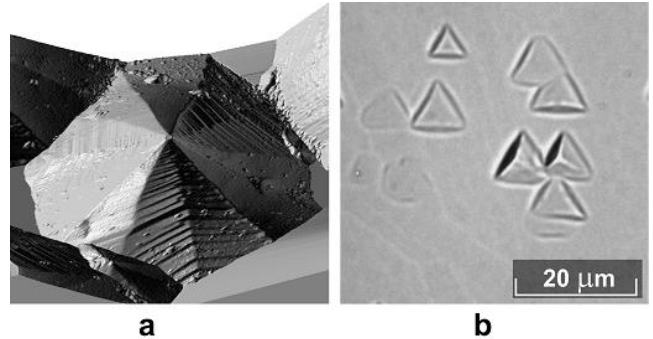
Figure 3. Microdomains in LN single crystals doped with REE: ( a ) 1.6 μm hexagonal microdomain nanostructure in an LiNbO 3 :Gd (0.44 wt.%) crystal on the Z-orientation etched surface; ( b ) the accumulation of triangular microdomains in the Z plane of the LiNbO 3 :Sm (1.1 wt.%) crystal. The image was obtained using an atomic-force microscope SMM-2000.